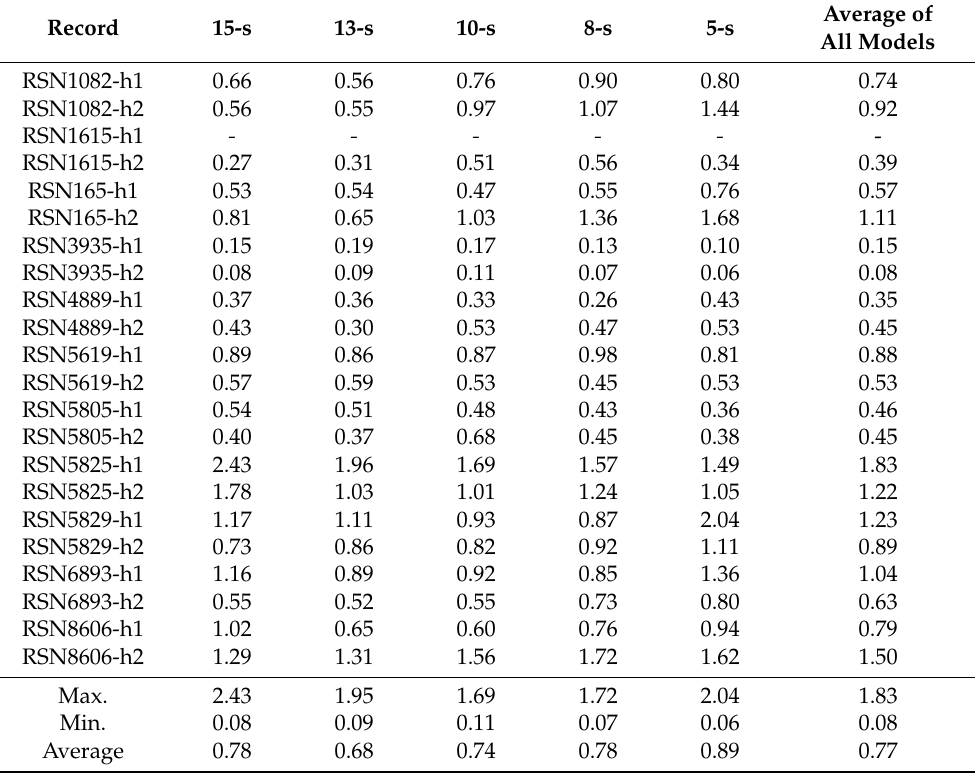
Table 7. Roof drift ratios (RDR) of building models